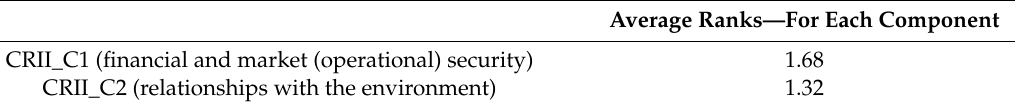
Table 28. Average ranks—for two components of CRII. Average Ranks—For Each Component